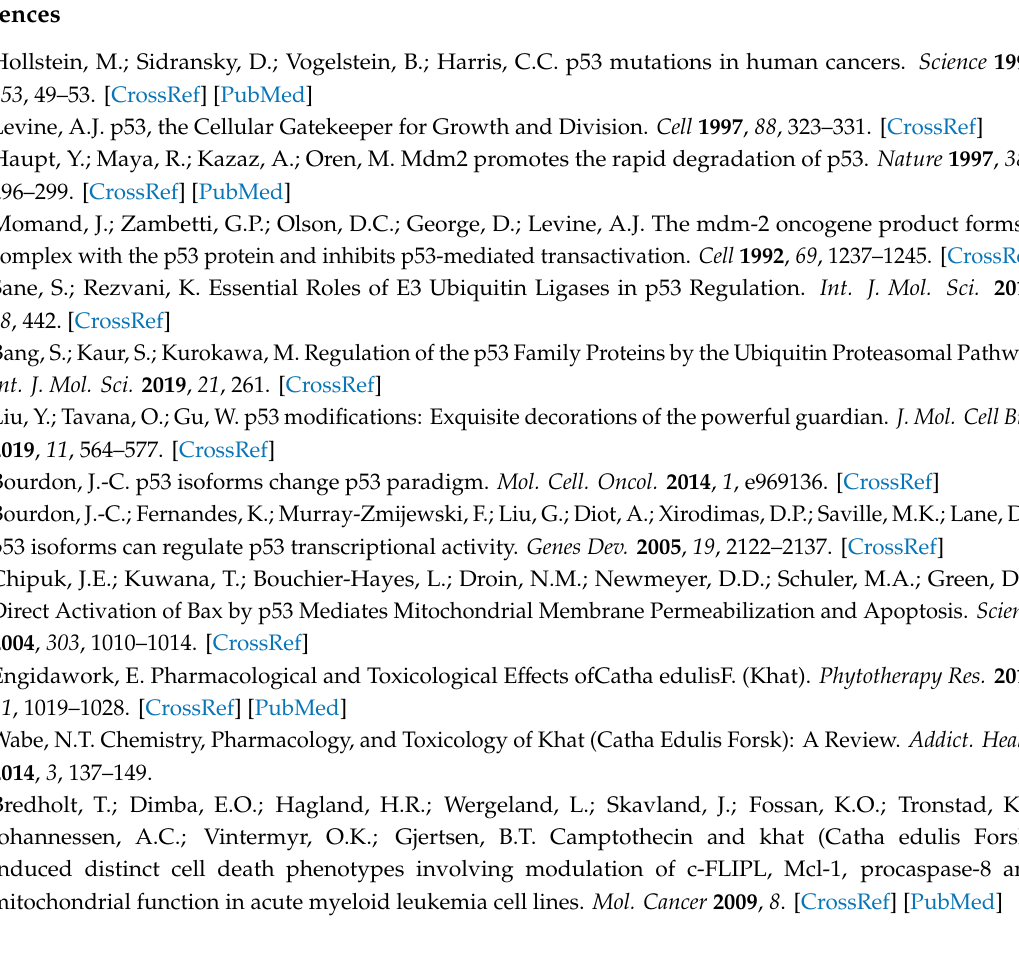
Figure S1: Western blot images in Figure 1C, Figure S2: Original figures of Figure 2A, Figure S3: Western blot images in Figure